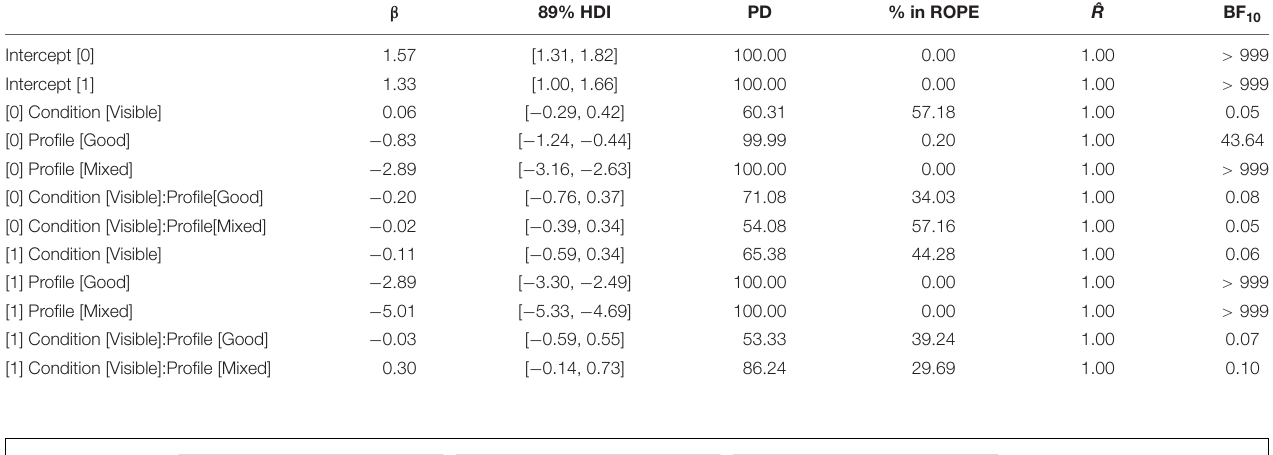
TABLE 3 | Summary of the model fitted to the bias data, considering the experimental condition (Visible or Reveal) and Profile type (Good, Mixed, and Bad).